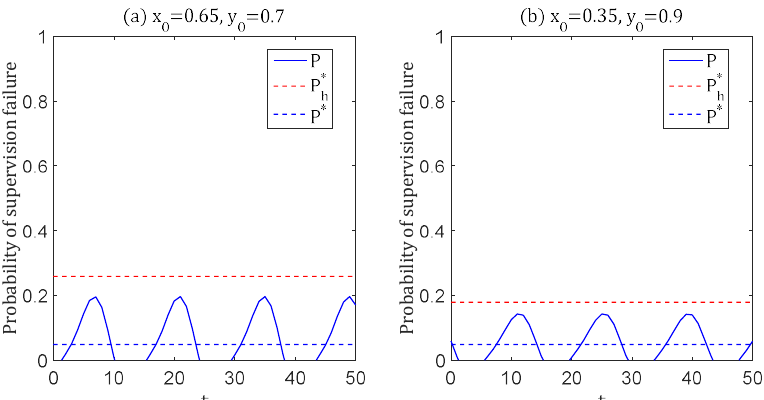
Figure 2. Effects of different initial states on the evolution of supervision. ( a ) Periodical fluctuation in proportions of strategies x and y in initial states ( 0.65, 0.7 ) . ( b ) Periodical fluctuation in proportions of strategies x and y in initial states ( 0.35, 0.9 ) .